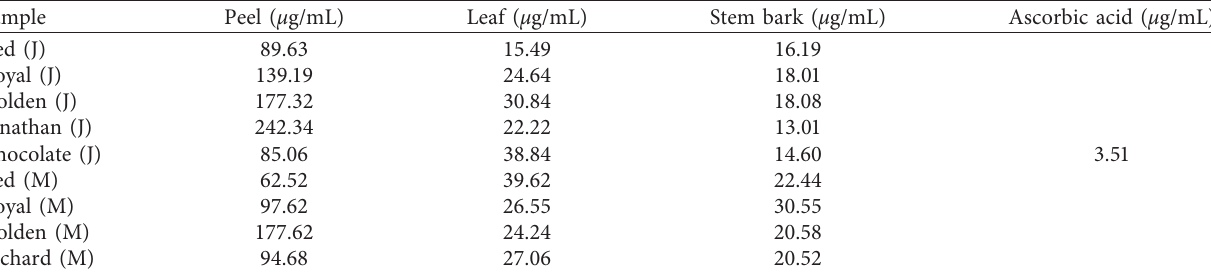
Figure 3: Total carbohydrate content of methanolic extract of pulp, peel, leaf, and stem bark in different M. domestica cultivars from two different regions of Nepal. Different letters (a–d) on bars indicate significant differences ( P < 0 . 05) between pulp, peel, leaf, and bark within the same cultivar. Table 3: IC 50 values of peel, leaf, and stem bark of different M. domestica cultivars from two different regions of Nepal along with ascorbic